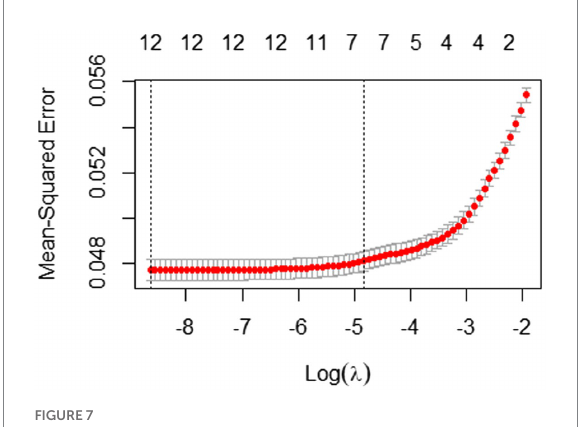
FIGURE 7 10-fold cross-validation result with mean-squared error for students with incorrect answers.